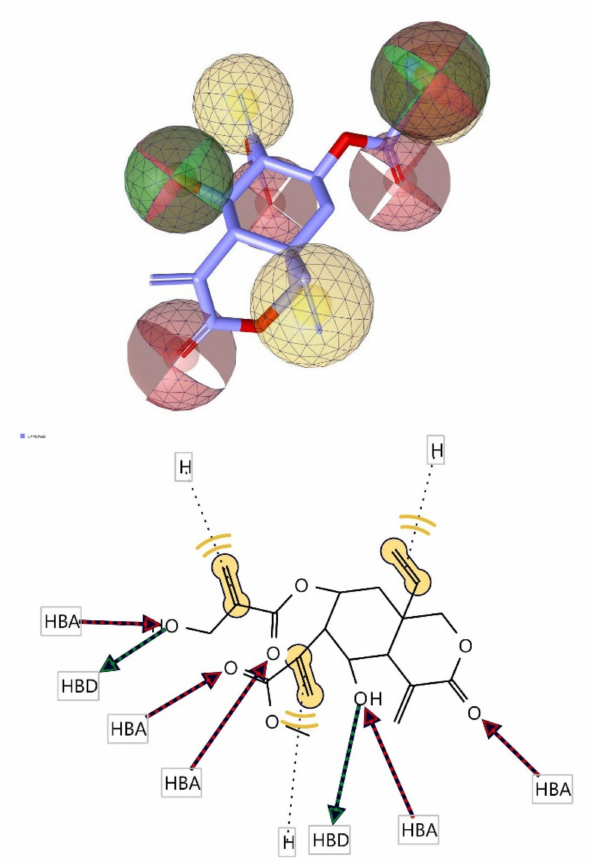
Figure 9. 3D and 2D representations of common pharmacophoric features of vernodalol used in pharmacophore evaluation. Red, HBAs; green, HBDs; Yellow, H; as described earlier.